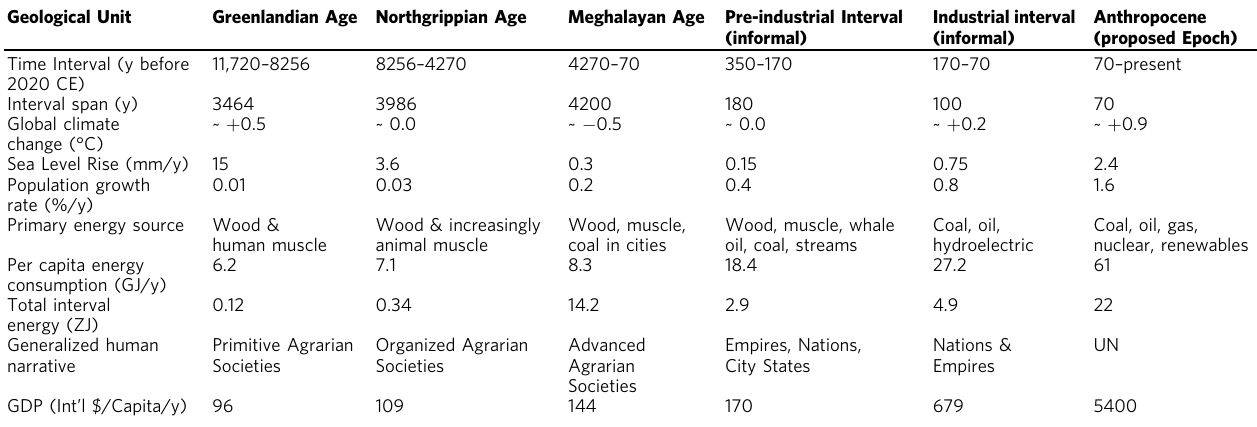
Table 1 Average values of key human and environmental drivers for each studied time